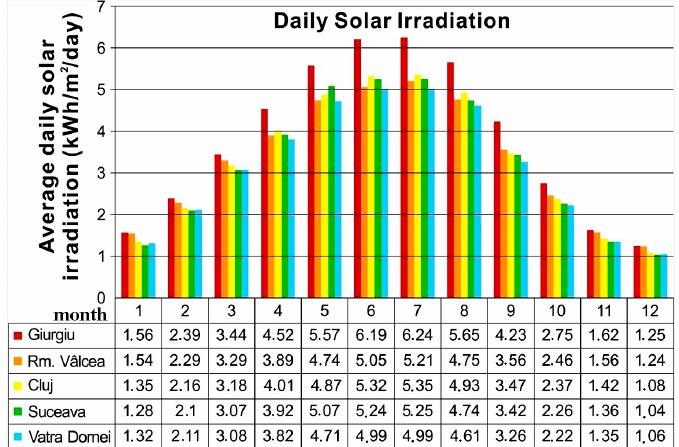
Figure 1. Daily solar irradiation [25].